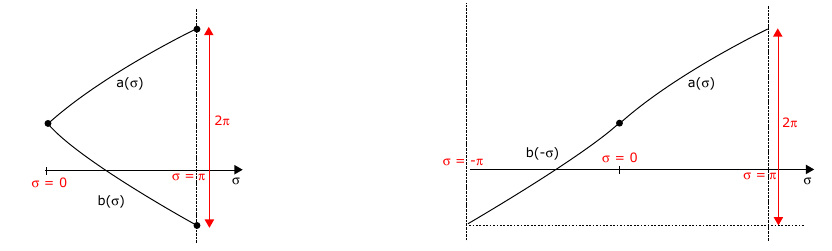
Figure 2 . Cylindrical surface with ZZ-branes at (cid:27) = 0 ; (cid:25) . The (cid:28) -coordinate is chosen periodic with period T .